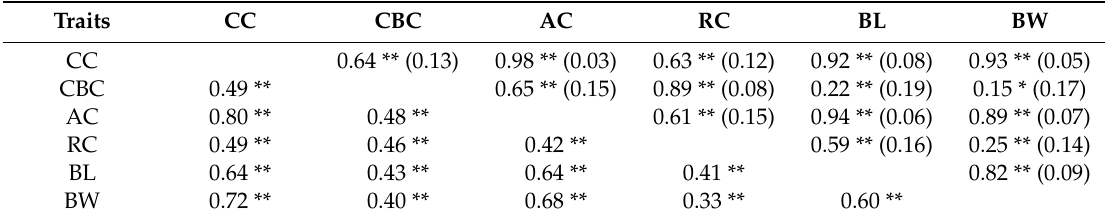
Table 3. Correlation analyses between body size and body weight in Suhuai gilts.